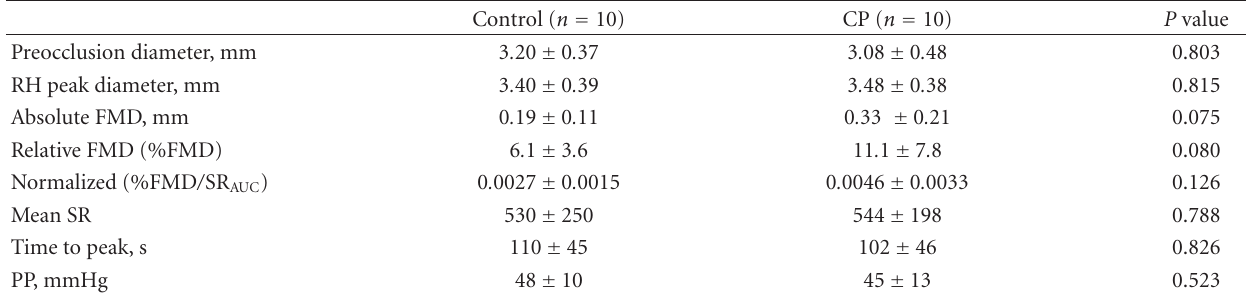
Table 2: Group comparisons of brachial vascular dimensions and FMD response.